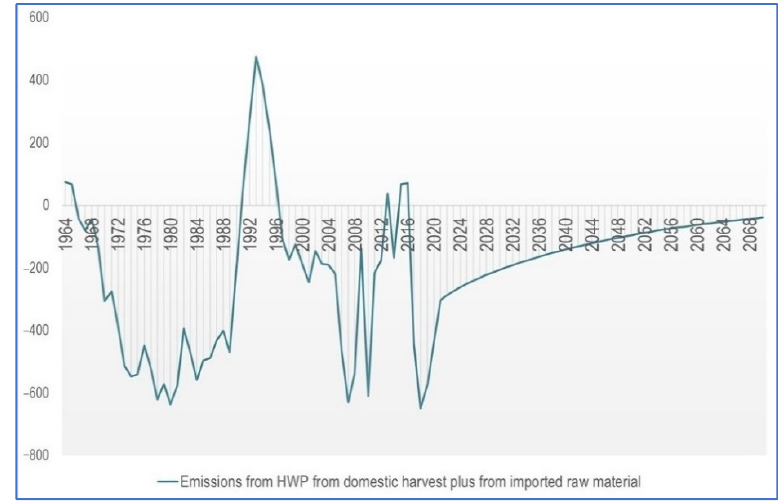
Figure 9. Historic and predicted emissions and removals from the HWP pool for time period of 1964–2070 (kt CO 2